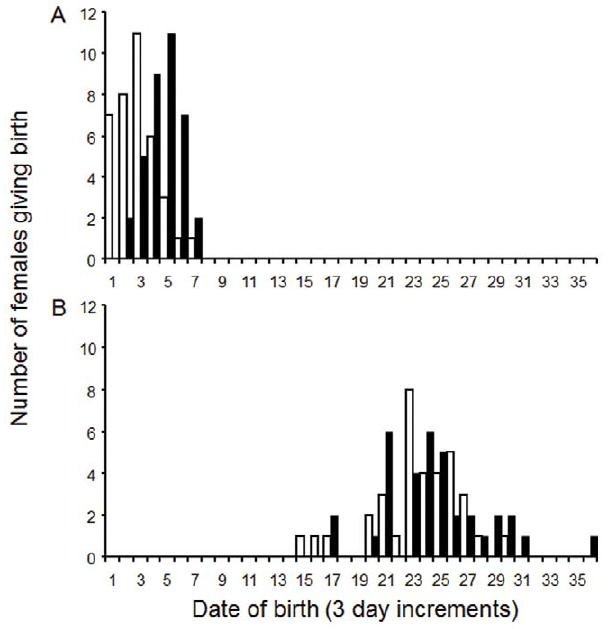
Figure 1. Frequency of births (3 day increments) for Pseudemoia entrecasteauxii . White bars indicate high food availability during gestation, while black bars indicate low food availability during gestation. Graph A shows date of birth in offspring from females given extended basking availability during gestation. Graph B shows date of birth in offspring from females given restricted basking availability during gestation. Three day increments begin with the first recorded births on Dec 7 2007.